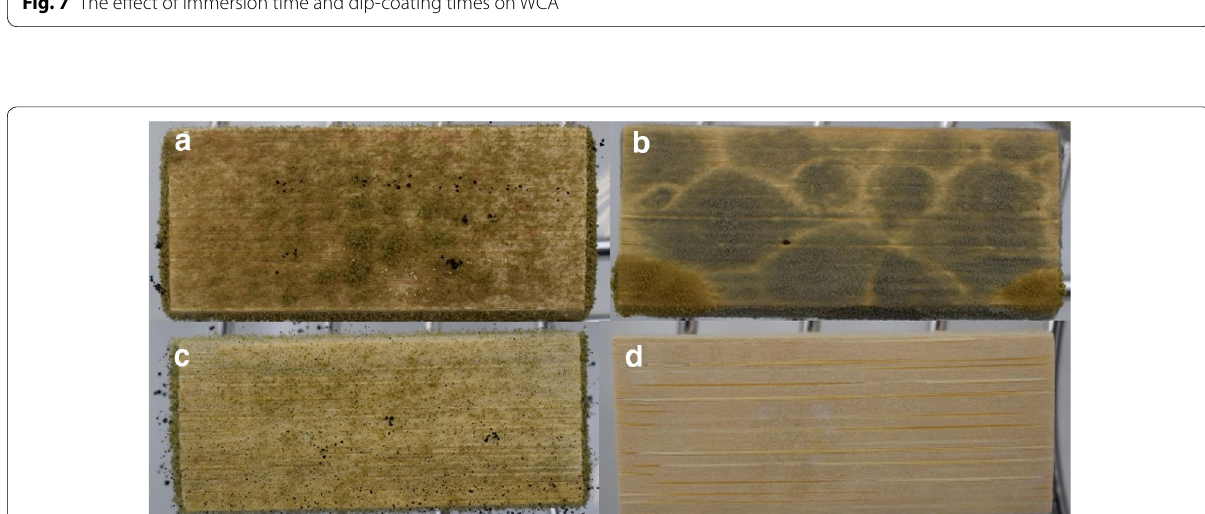
Fig. 8 Typical pictures of unmodified bamboo ( a ) and modified bamboo with Cu(OH) 2 ( b ), PMS ( c ) and PMS/CuNP ( d ) in anti-mildew test after 4